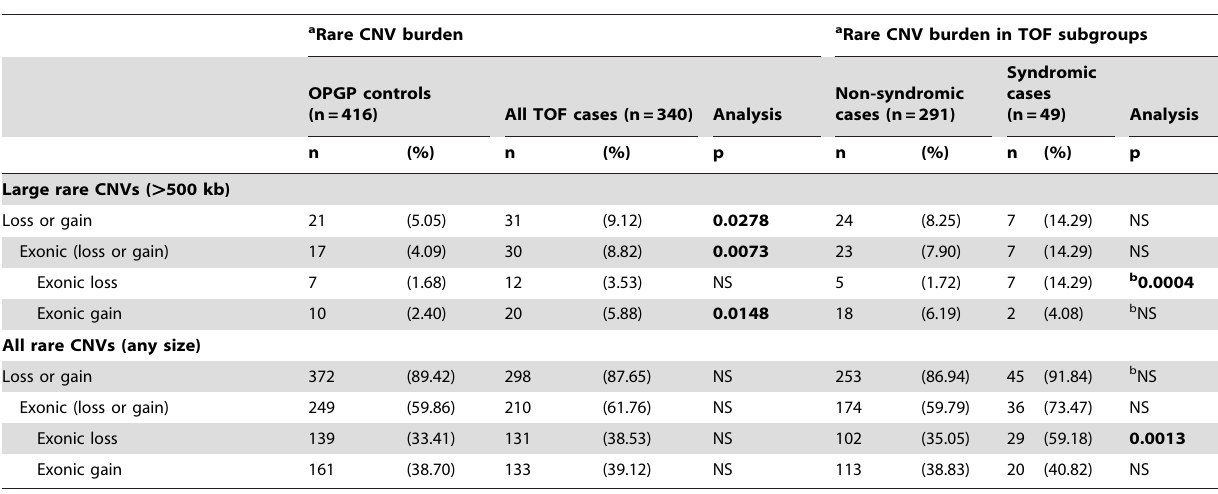
Table 1. Rare CNV burden in 340 unrelated adults with tetralogy of Fallot and/or pulmonary